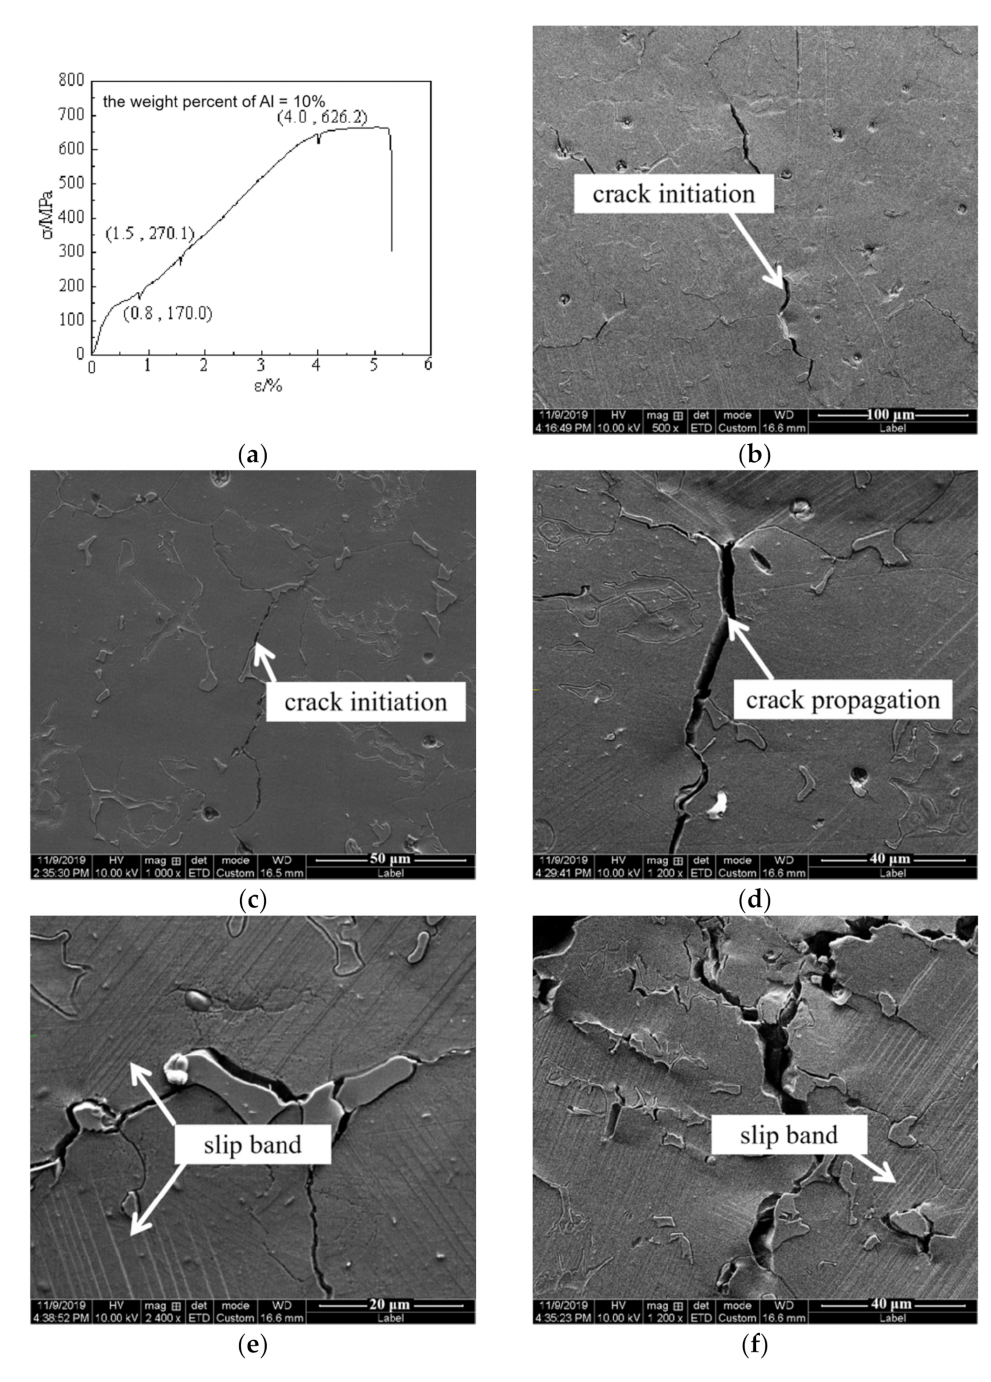
Figure 8. Crack evolution process of Fe-25Mn-10Al-8Ni-C alloy, ( a ) stress–strain curve; ( b ) ε = 0.8%, σ = 170.0MPa, 500 × ; ( c ) ε = 0.8%, σ = 170.0 MPa,1000 × ; ( d ) ε = 1.5%, σ = 270.1 MPa, 1200 × ; ( e ) ε = 1.5%, σ = 270.1 MPa, 2400 × ; ( f ) ε = 4.0%, σ = 626.2 MPa, 1200 ×